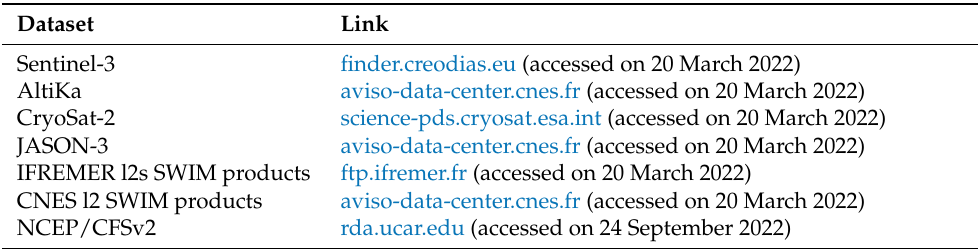
Table 1. Links to the datasets used in this